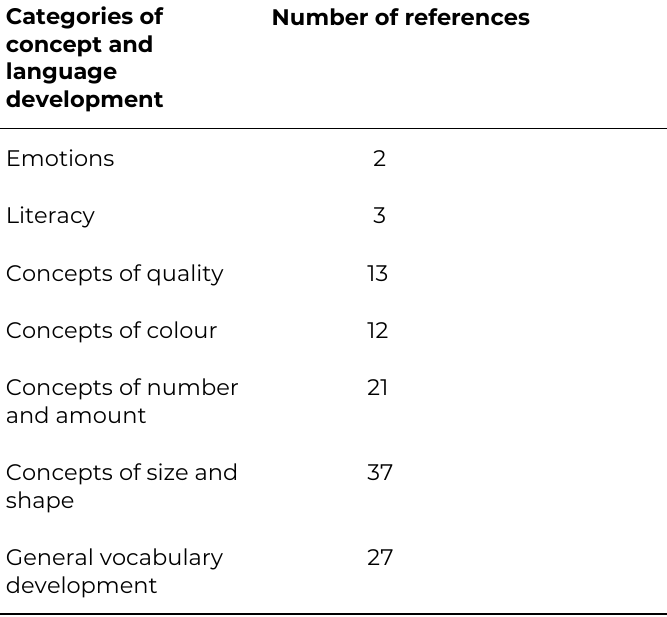
Table 2. Categories within the subtheme of concept and language development in the interactions between children and